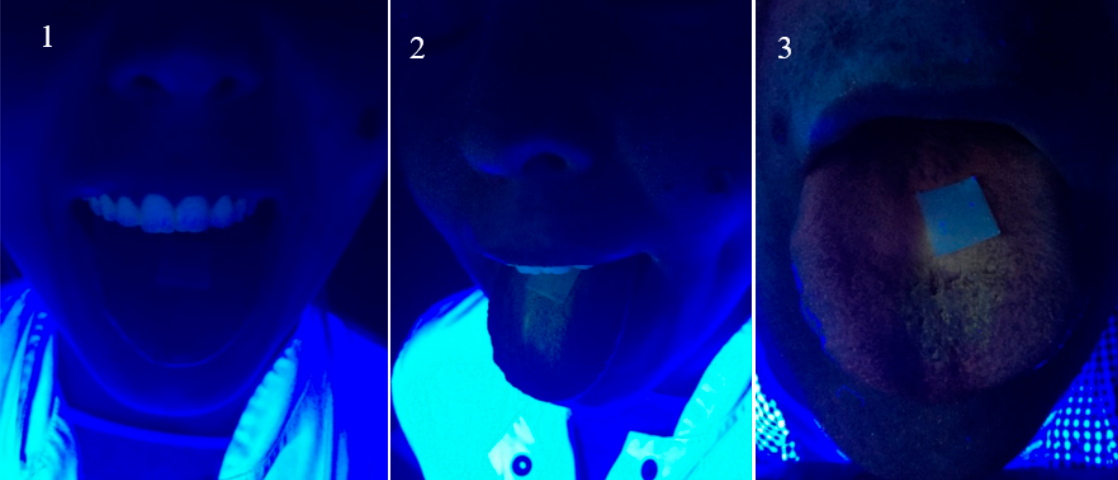
Figure 2. Proof of the principle showing microbial-induced hydrolysis of glucosidic β -D-bond. Picture 1: fluorescein glycoside-soaked paper is placed on the tongue surface. Picture 2: liberation of fluorescein resulting in shining of a UV light after 15 s of incubation on the tongue surface. Picture 3: Fluorescein detection (in 20 sec.) liberated from glucoside after being washed in mouth three times with a mixture of water with Octenisept 1:1, v / v .